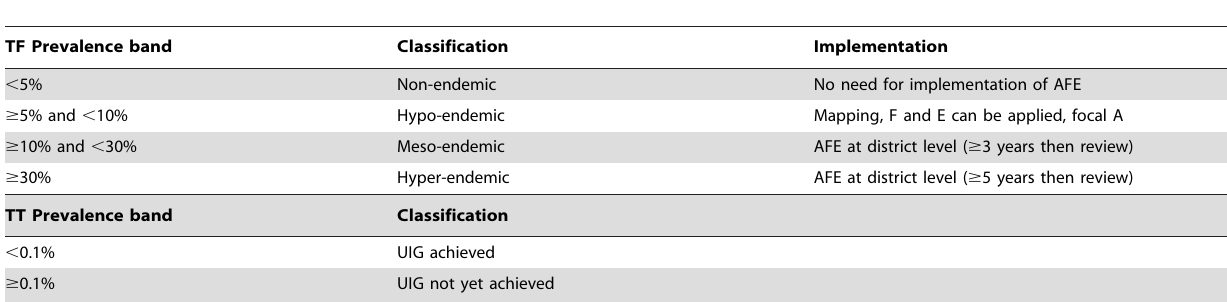
Table 1. Endemicity classes for implementation of SAFE based on trachomatous inflammation–follicular (TF) and trichiasis (TT).